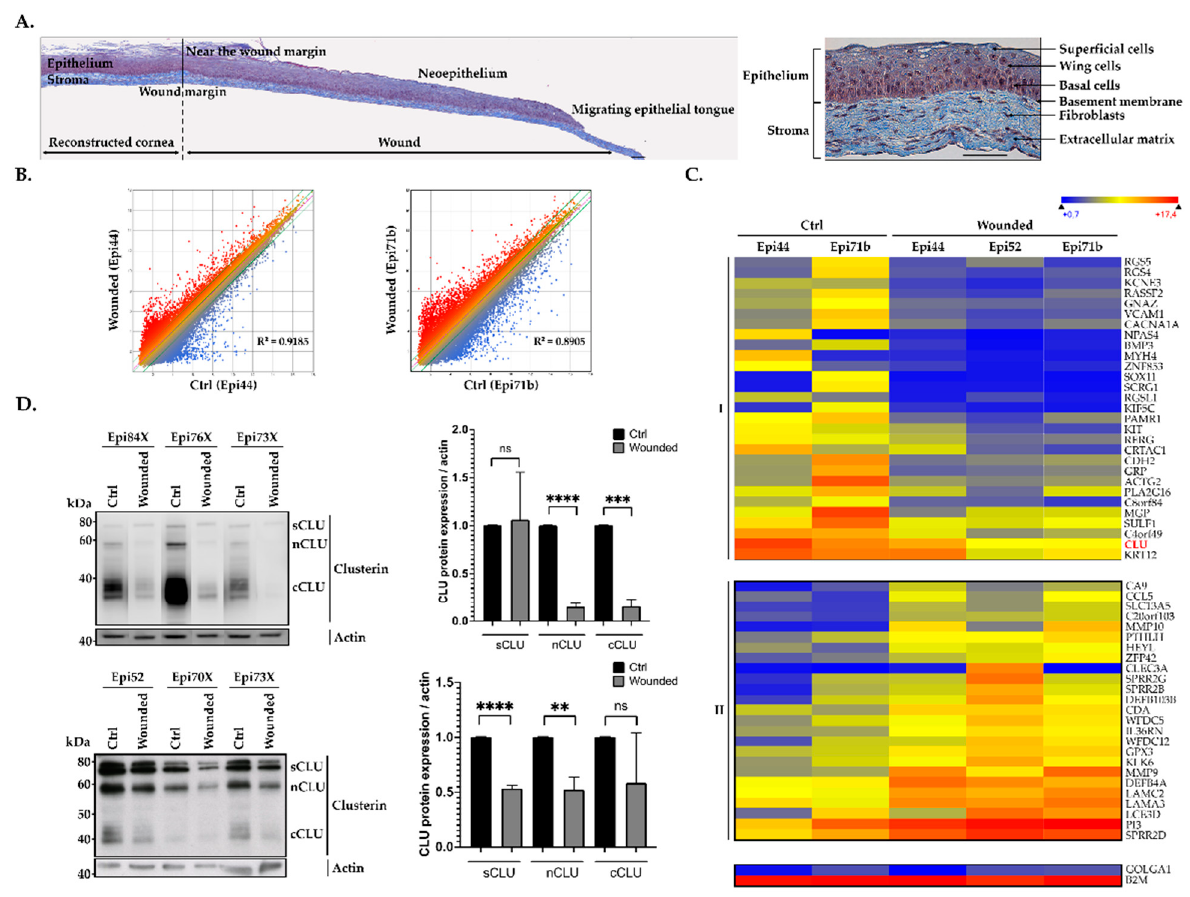
Figure 1. Gene expression patterns in response to corneal damage. ( A ) Composite images showing a complete histological (Masson’s Trichrome staining cells are pink and collagen is blue) view of wounded HTECs (with Epi52) at 4 days following corneal damage (left panel) and unwounded hTECs as a control (right panel). The wound margin created by the biopsy punch and the various elements which composed hTECs are indicated. Scale bar: 50 µ m. ( B ) Scatter plot of log2 of signal intensity from 60,000 different targets covering the entire human transcriptome of cells isolated from the central area of wounded hTECs (in the y-axis ) plotted against cells from unwounded hTECs (in the x-axis ) and assembled using either Epi44 (left panel) or Epi71b (right panel) hCECs. ( C ) Heatmap representation of the 54 most deregulated genes expressed by centrally wounded relative to unwounded (negative control) hTECs. The color scale used to display the log2 expression level values is determined by the Hierarchical clustering algorithm of the Euclidian metric distance between genes. Genes indicated in dark blue correspond to those whose expression is very low, whereas highly expressed genes are shown in orange/red. Microarray data for the housekeeping genes β 2-microglobulin ( B2M ) and golgin subfamily A member 1 ( GOLGA1 ) that are expressed respectively to very high and low levels in all types of cells are also shown. ( D ) Western blot (left panel) and quantification analysis (right panel) of CLU protein isoforms either in hTECs (top panel) or in human epithelial corneal cells (bottom panel). Actin is also shown as an internal control. **: Values considered to be statistically significant from those obtained with the control (Ctrl) protein extract ( p value < 0.001). ***: Values statistically significant from those obtained with the control (Ctrl) protein extract ( p value < 0.001). ****: Values statistically significant from those obtained with the control (Ctrl) protein extract ( p value < 0.0001). ns: Values considered to be statistically non-significant.